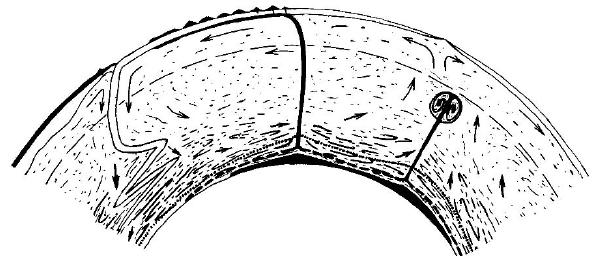
Fig. 1. Sketch of the mantle, with lithosphere and continental crust roughly to scale. The main dynamical elements of the mantle are included: subducting lithosphere and rising mantle plumes. Arrows indicate the flow associated with the plates. Chemical heterogeneity is included schematically. The D 00 at the bottom includes a discon- tinuous denser layer (black), plume feeding zone (heavy dashes) and thermal boundary layer (dotted). From Davies (1990b). Copy- right Elsevier Science. Reprinted with